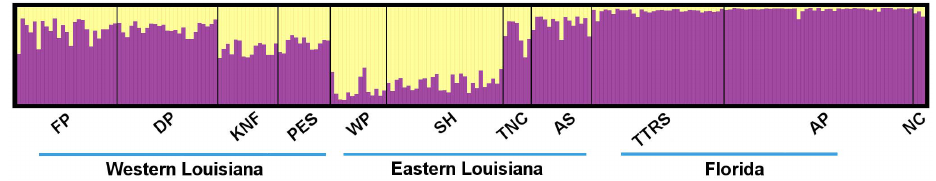
Figure 5. STRUCTURE plot with LocPrior for K=2 populations. Each column represents an individual, each color denotes a population cluster. Population abbreviations are as follows: Abita Springs (AS), Avon Park (AP), Dry Prong (DP), Fort Polk WMA (FP), Kisatchie National Forest (KNF), North Carolina (NC), Palustris Experimental Forest (PEF), Sandy Hollow WMA (SH), Tall Timbers Research Station (TTRS), Talisheek Pine Wetlands Preserve (TNC), Camp Whispering Pines (WP).